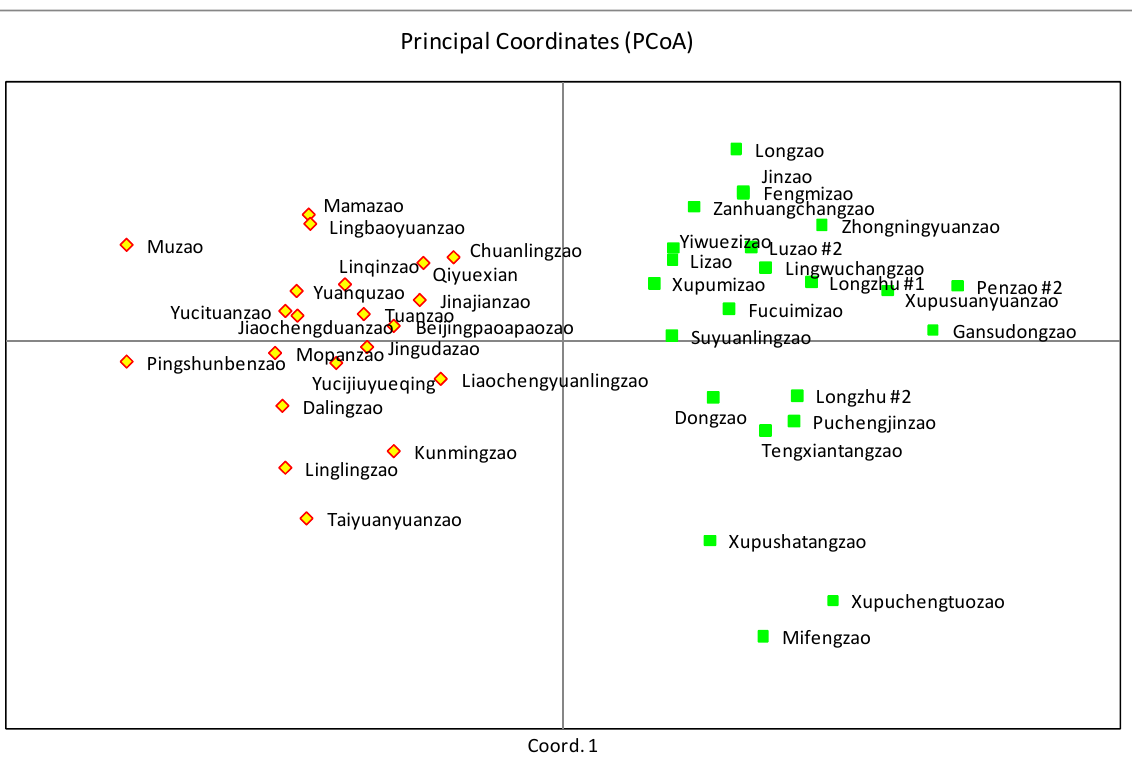
Figure 5. Principle Coordinate Analysis of the two distinctive jujube cultivar groups in 43 cultivars. The NJ tree revealed additional insight that is complementary to those presented by PCoA and Bayesian stratification (Figure 6). The NJ tree classified the jujube cultivars into 20 small sub-clusters, which were deeply separated. However, each of these 20 subclusters comprised 1–13 closely related cultivars. Some of these sub-clusters, such as Huizao, Ruchengzao, Lizao, Longzhu 1, etc. reflected specific geographical origins.